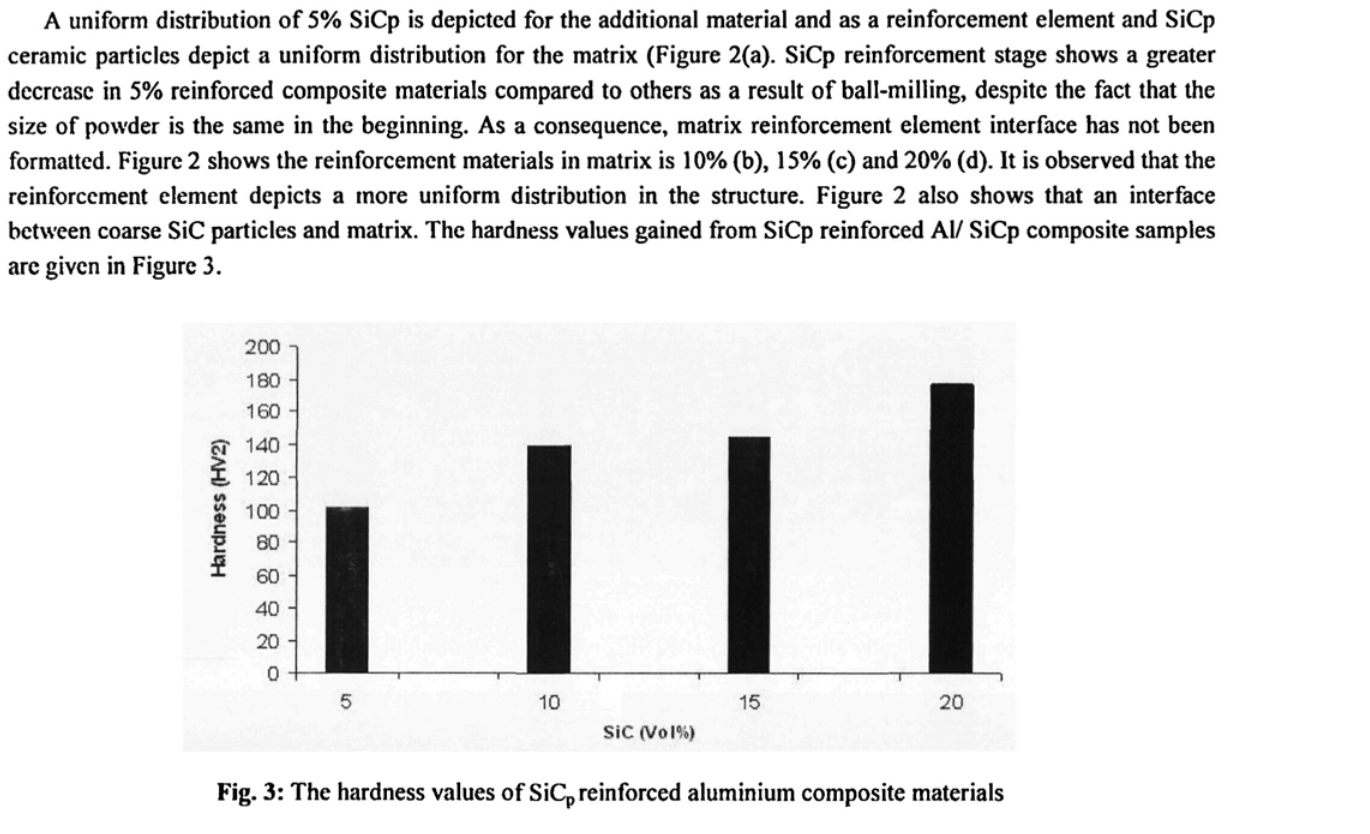
Fig. 3: The hardness values of SiC